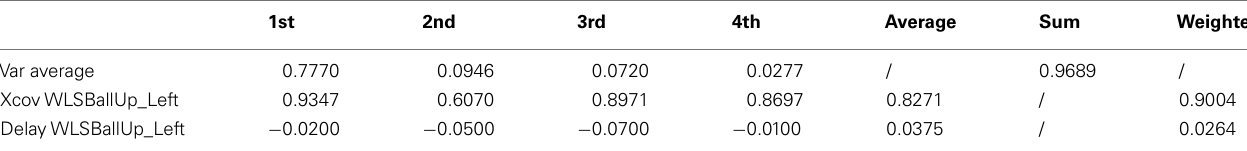
Table 8 | Reaching a target with the left hand while walking (2